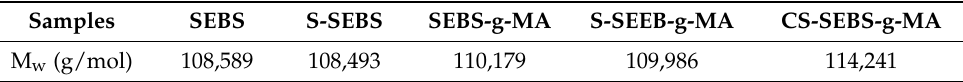
Table 1. Average of M w S-SEBS, SEBS-g-MA, S-SEBS-g-MA, and cross-linked S-SEBS-g-MA membranes.